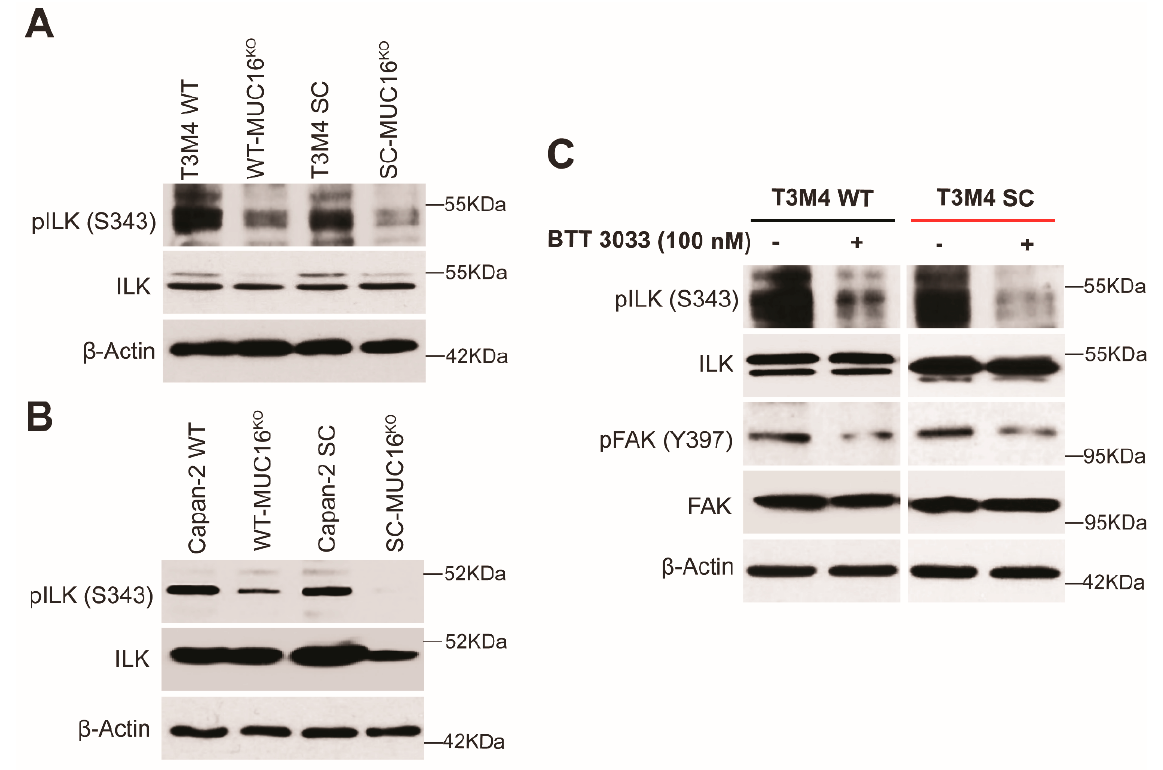
Figure 4. Truncated O-glycan-bearing MUC16 potentiates integrin signaling. Western blot analysis showing ( A ) phosphorylation of ILK at Serine 343 (pILK S343) and total ILK in T3M4 WT, WT- MUC16 KO , SC, SC-MUC16 KO cells; loading control: β -actin and in ( B ) Capan-2 WT, WT-MUC16 KO , SC, SC-MUC16 KO cells; loading control: β -actin; ( C ) pILK (S343) and pFAK (Y397) in T3M4 WT and SC cells treated with the integrin inhibitor, BTT 3033 (100 nM), for 24 h (control: untreated); loading control: β -actin.